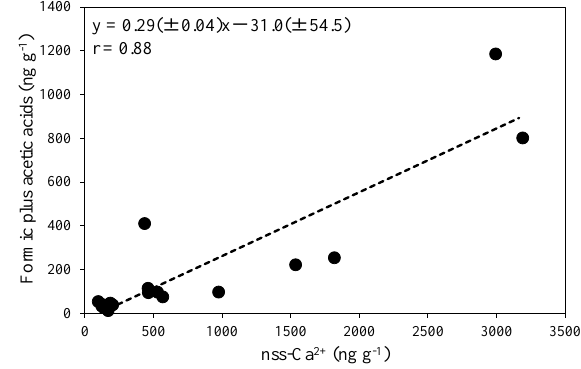
Figure 5. Scatter plot of concentrations of formic plus acetic acids vs. nss–Ca 2 + in Mt. Tateyama snow samples. The dotted line rep- resents the Deming linear